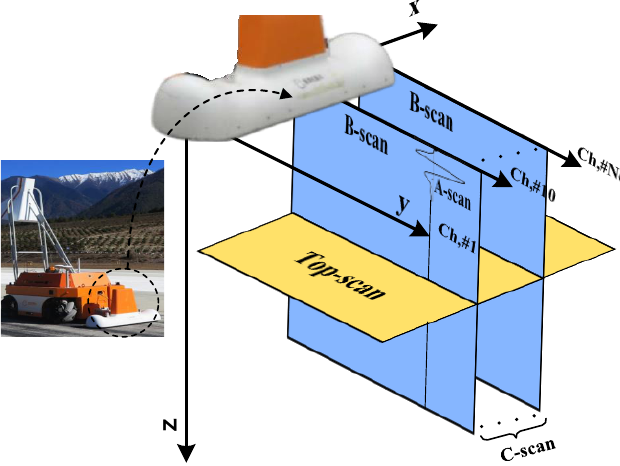
Figure 3. GPR antenna and 3D GPR data arrangement.